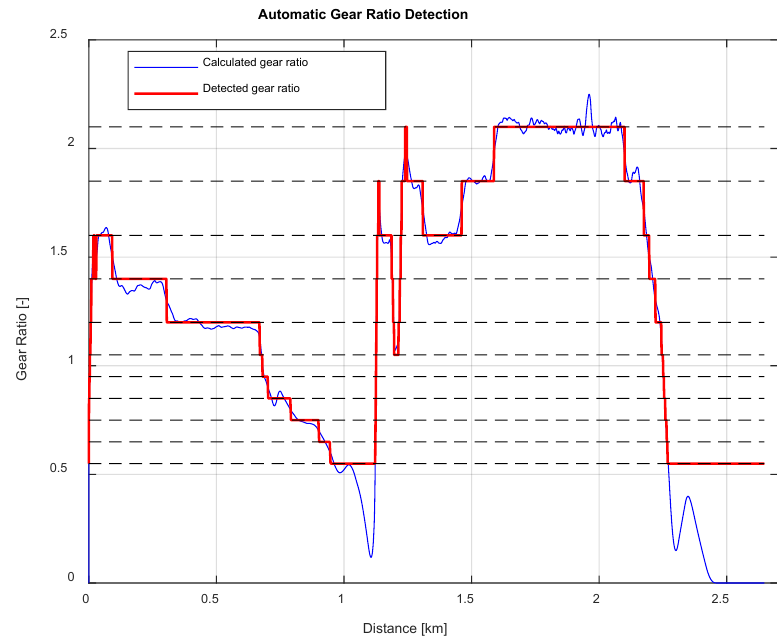
Figure 7. The results of the current gear ratio automatic detection.